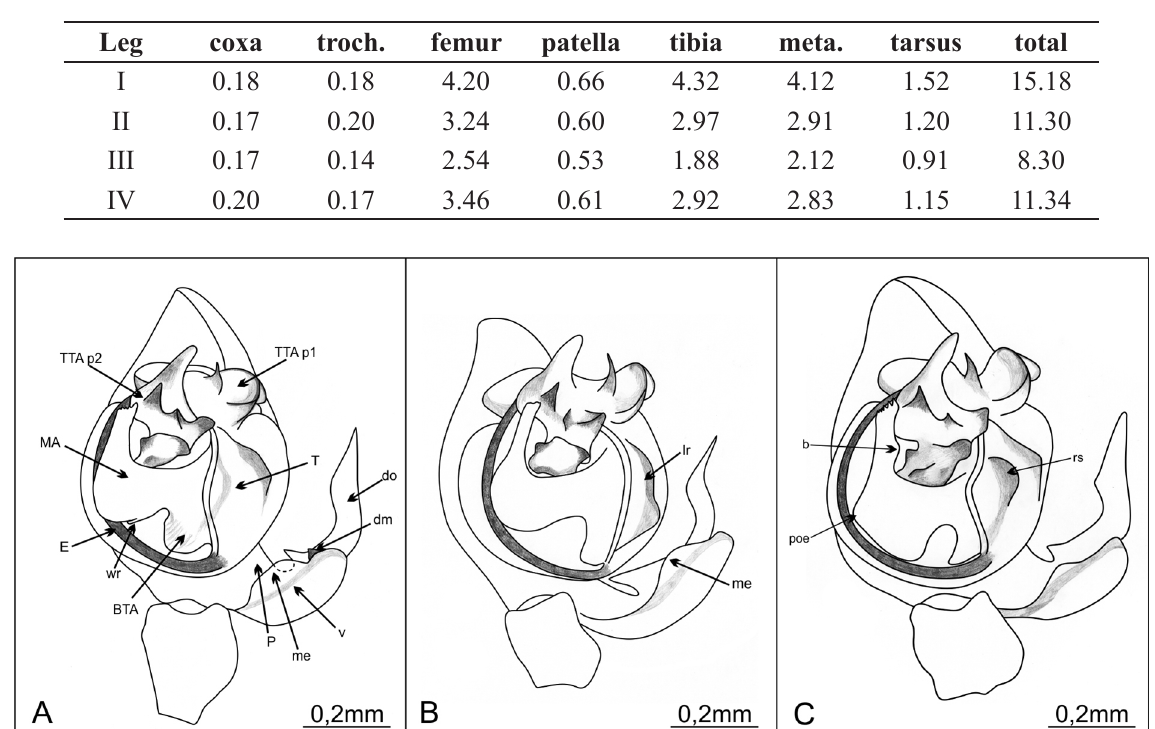
Fig 2. Male bulbus . A . Kryptonesticus deelemanae gen. et sp. nov. B . K. fagei (Kratochvíl, 1933). C. K. arenstorffi (Kulczyński,